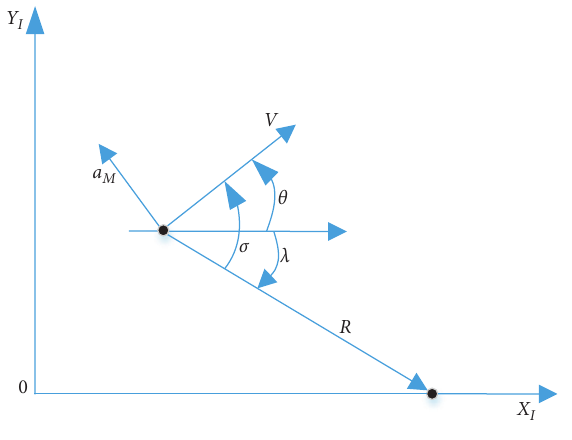
Figure 1: Engagement